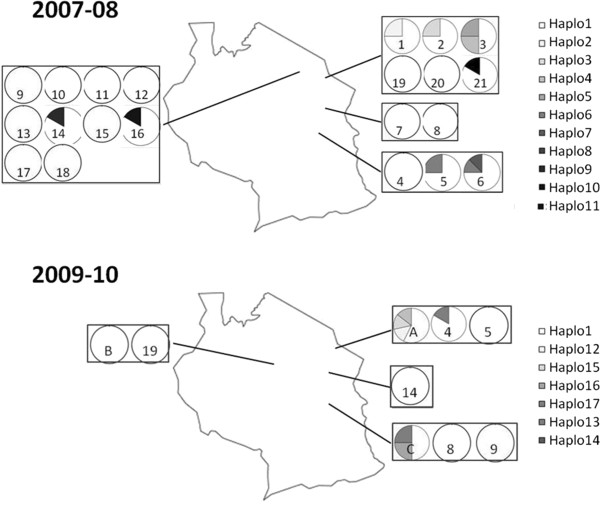
 The spatial prevalence of COI hapolotypes within armyworm larval populations sampled throughout Tanzania over the course of two field seasons. The numbers correspond to the field sites in Additional file 1: Table S1, numbered sequentially through the season. A, B and C refer to the moth trap catches from those districts.